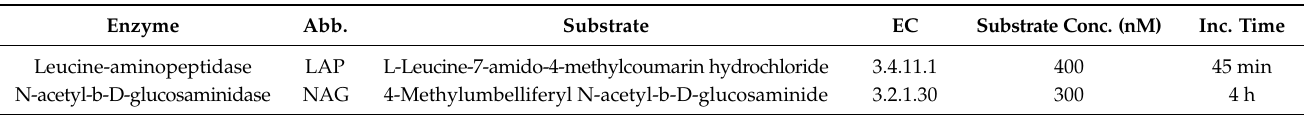
Table 2. Soil enzymes assayed for potential activity along with their enzyme commission number (EC), abbreviation, substrate and incubation